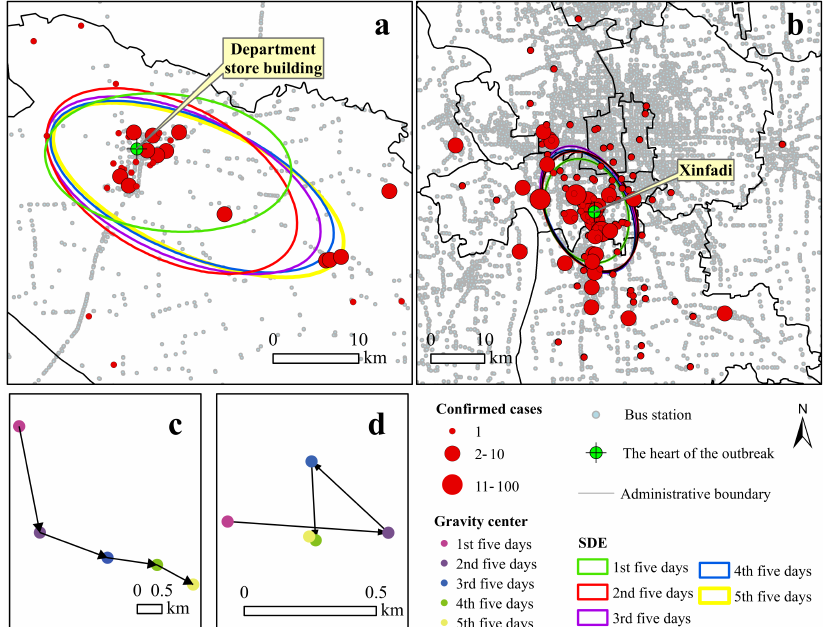
Figure 3. Spatiotemporal distribution of cases: ( a , b ) the distribution range and diffusion direction of confirmed cases of DSB and XFD in five time periods, respectively; ( c , d ) the change in direction of the ellipse center of DSB and XFD,